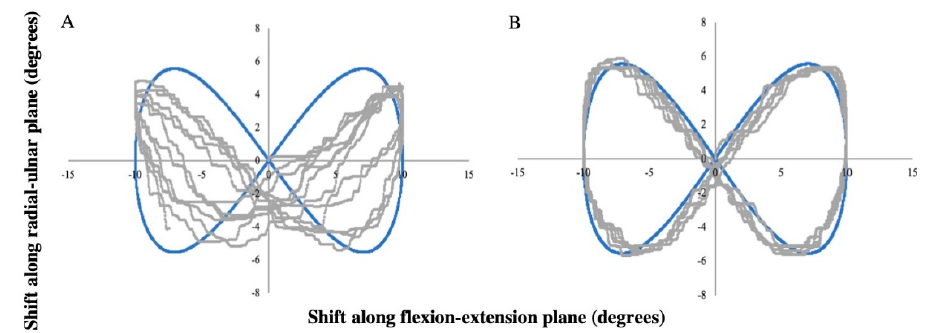
Figure 4. Figural error displayed for S06 at T0 ( A ) compared to T1 ( B ) for the trained limb. Significant reduction in figural error from pre-post intervention ( p = 0.03). Blue line represents target trajectory, and the grey line represents the participant’s trace attempt for each of the 6 laps.